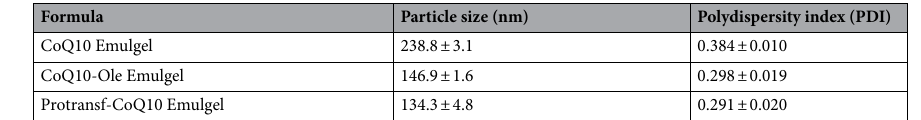
Table 1. Particle Size and polydispersity index of CoQ10 loaded in emulgel (CoQ10 Emulgel), CoQ10 dissolved in oleic acid (CoQ10-Ole) Emulgel, and protransfesomal CoQ10 (Protransf-CoQ10) Emulgel. Each value represents the mean ± SD (n = 3).